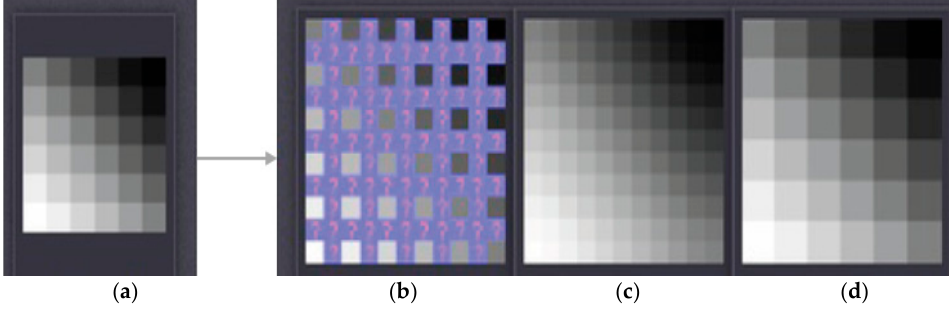
Figure 3. Bi-cubic interpolation effects: ( a ) input image, ( b ) before interpolation, ( c ) after interpolation, and ( d ) no interpolation. and ( d ) no